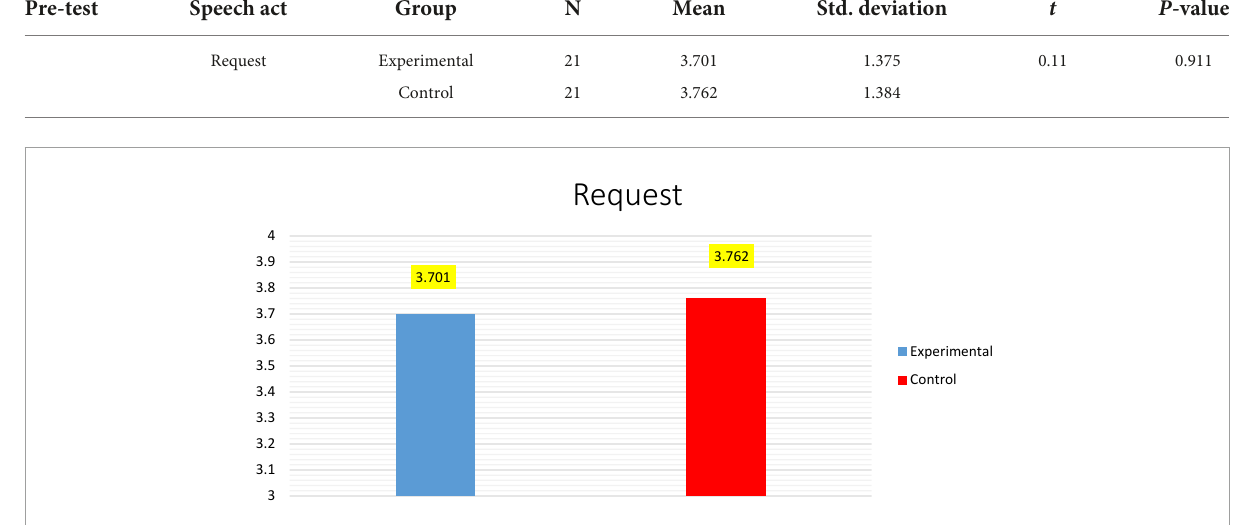
TABLE 2 Independent sample t -test between the experimental and control groups for pre-test (Request).